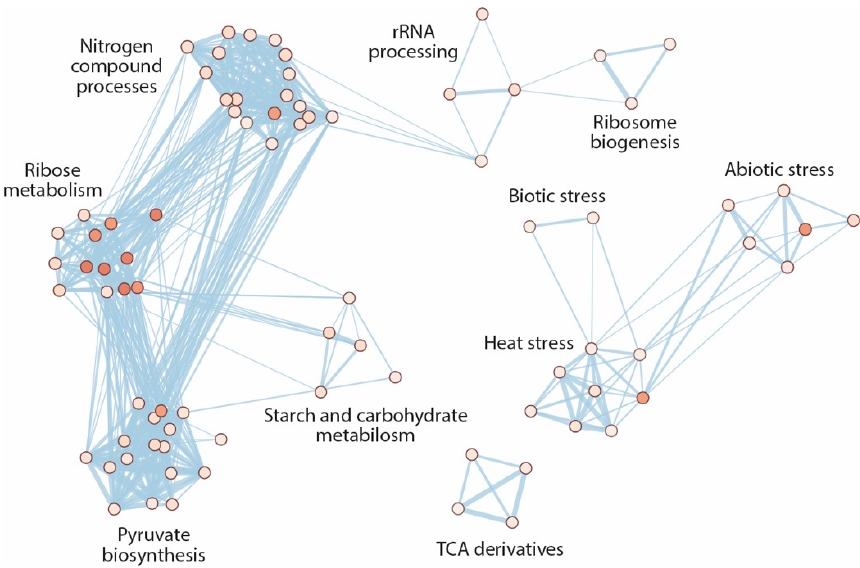
Figure 6. Gene Ontology (GO) term enrichment map for downregulated DEGs. GO terms that share members are shown in connected clusters. Cluster labels were retrieved using the AutoAnnotate v1.3.3 application in Cytoscape. The node color intensity reflects the normalized enrichment score (NES) of the underrepresented terms (white to red) with red marking the highest NES. The node size gives account on the number of members in the particular GO term.